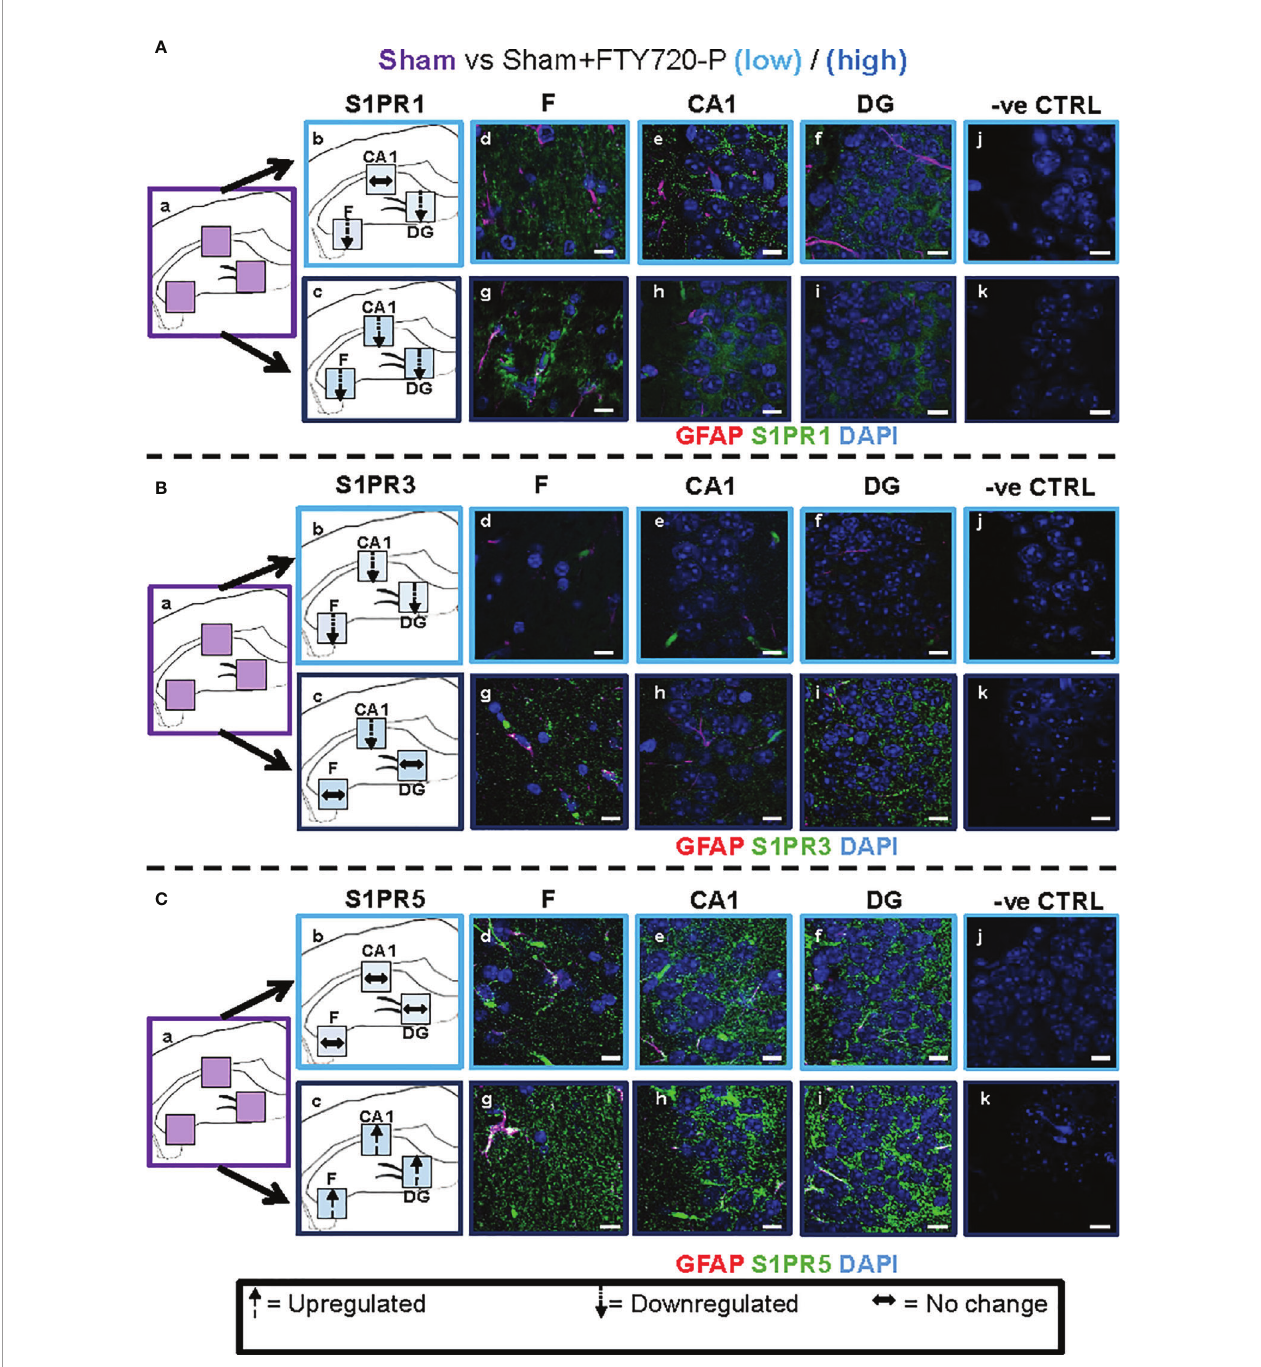
FIGURE 5 | Direct FTY720 effect on S1PR1, S1PR3 and S1PR5 expression in the hippocampus. Comparison of S1PR expression between sham, sham+FTY720- Lo and sham+FTY720-H groups. The left-hand panel shows the regions of interest (Aa-c, Ba-c, Ca-c) and the direction of change in three hippocampal sub- fi elds for each S1PR (downregulation = dotted arrow, upregulation = dashed arrow, or no change = horizontal arrow). The main panel shows immunostained sections with anti-GFAP (red) and anti-S1PR1 (green; Ad-f, g-i ), anti-S1PR3 (green; Bd-f, g-i ) or anti-S1PR5 (green; Cd-f, g-i) ; nuclei were stained with DAPI. Original images for Aa, Ba and Ca are found in Figure 4 . No primary antibody controls are shown in Aj-k, Bj-k and Cj-k ). N = 4 mice/group × 6 sections/mouse. Scale bars = 10 µm. Experiments were replicated 3 times. Quanti fi cation of images is shown in Figure 7